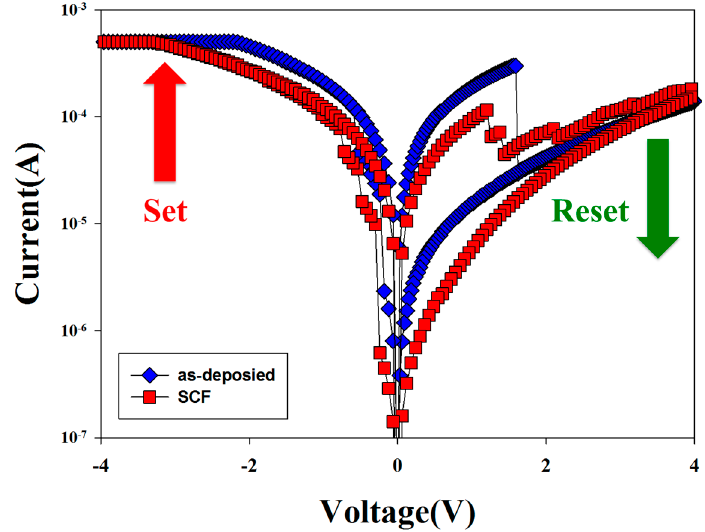
Figure 4. Bipolar switching curves of non-treated and supercritical carbon dioxide fluid (SCF)-treated neodymium oxide thin films.